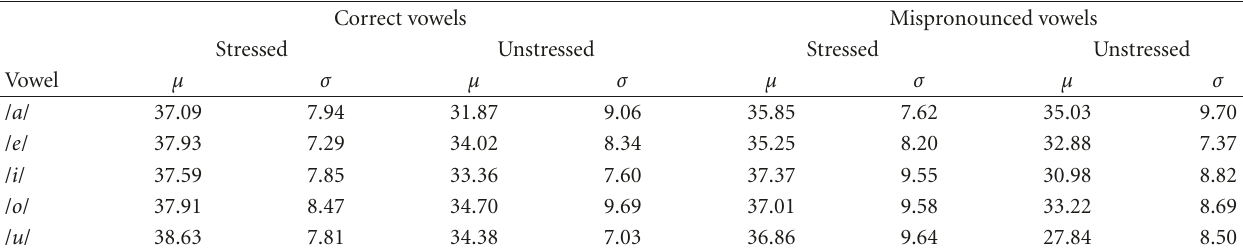
Table 11: Mean ( μ ) and standard desviation ( σ ) of energy in the impaired corpus.